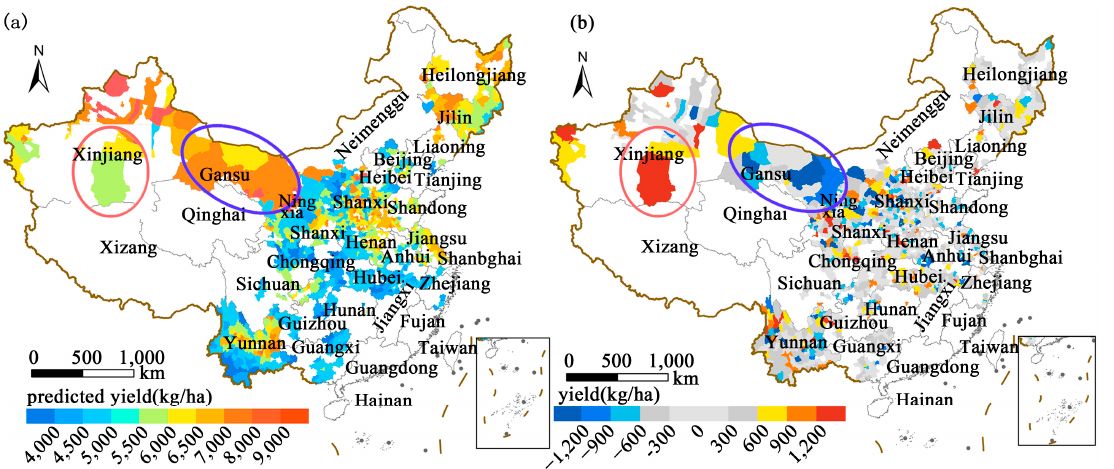
Figure 10. Spatial distribution of ( a ) observed yield in 2018 and ( b ) difference between observed and estimated yields in 2018.